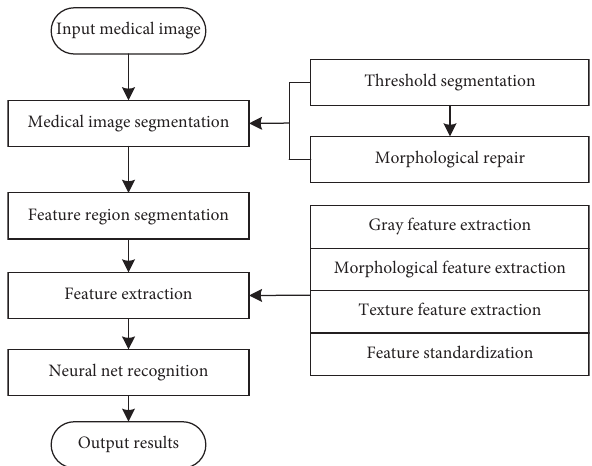
Figure 5: Medical image feature extraction and recognition